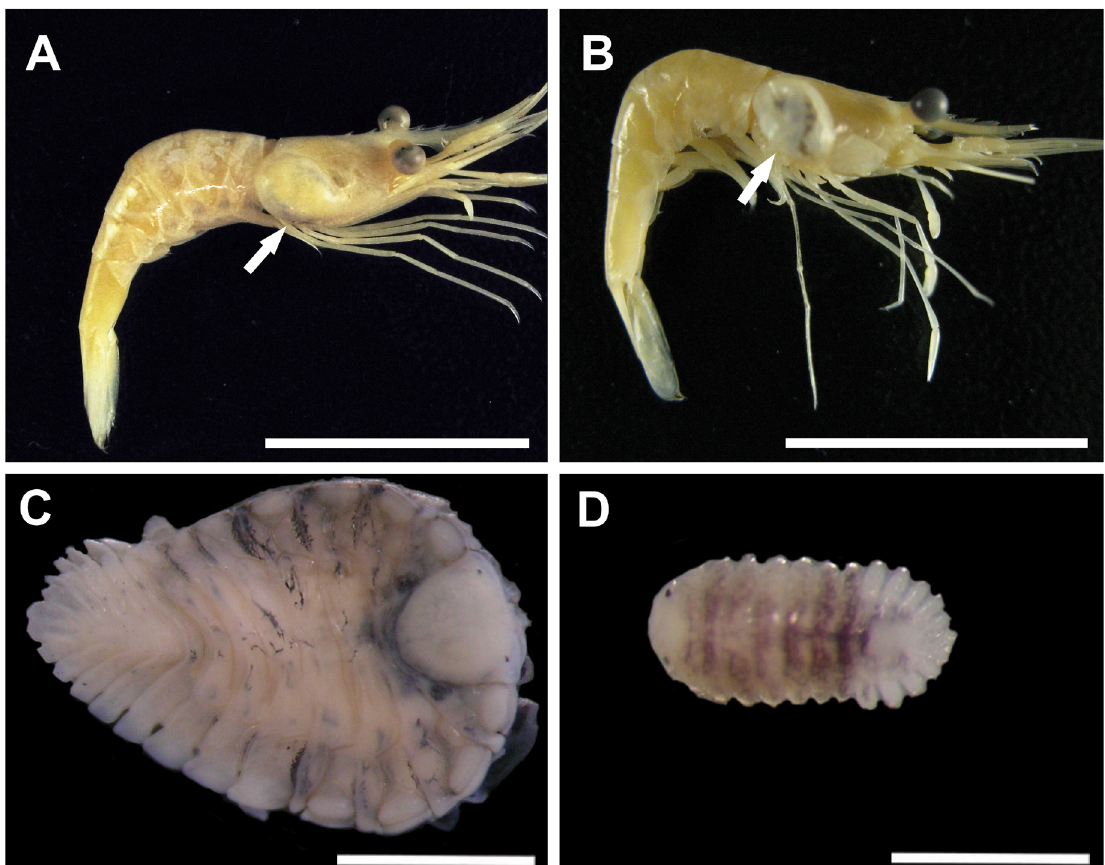
Figure 1. Lateral view of Palaemon northropi (A) and Palaemon pandaliformis (B) infested by Probopyrus sp. (arrow). Scale bar = 5